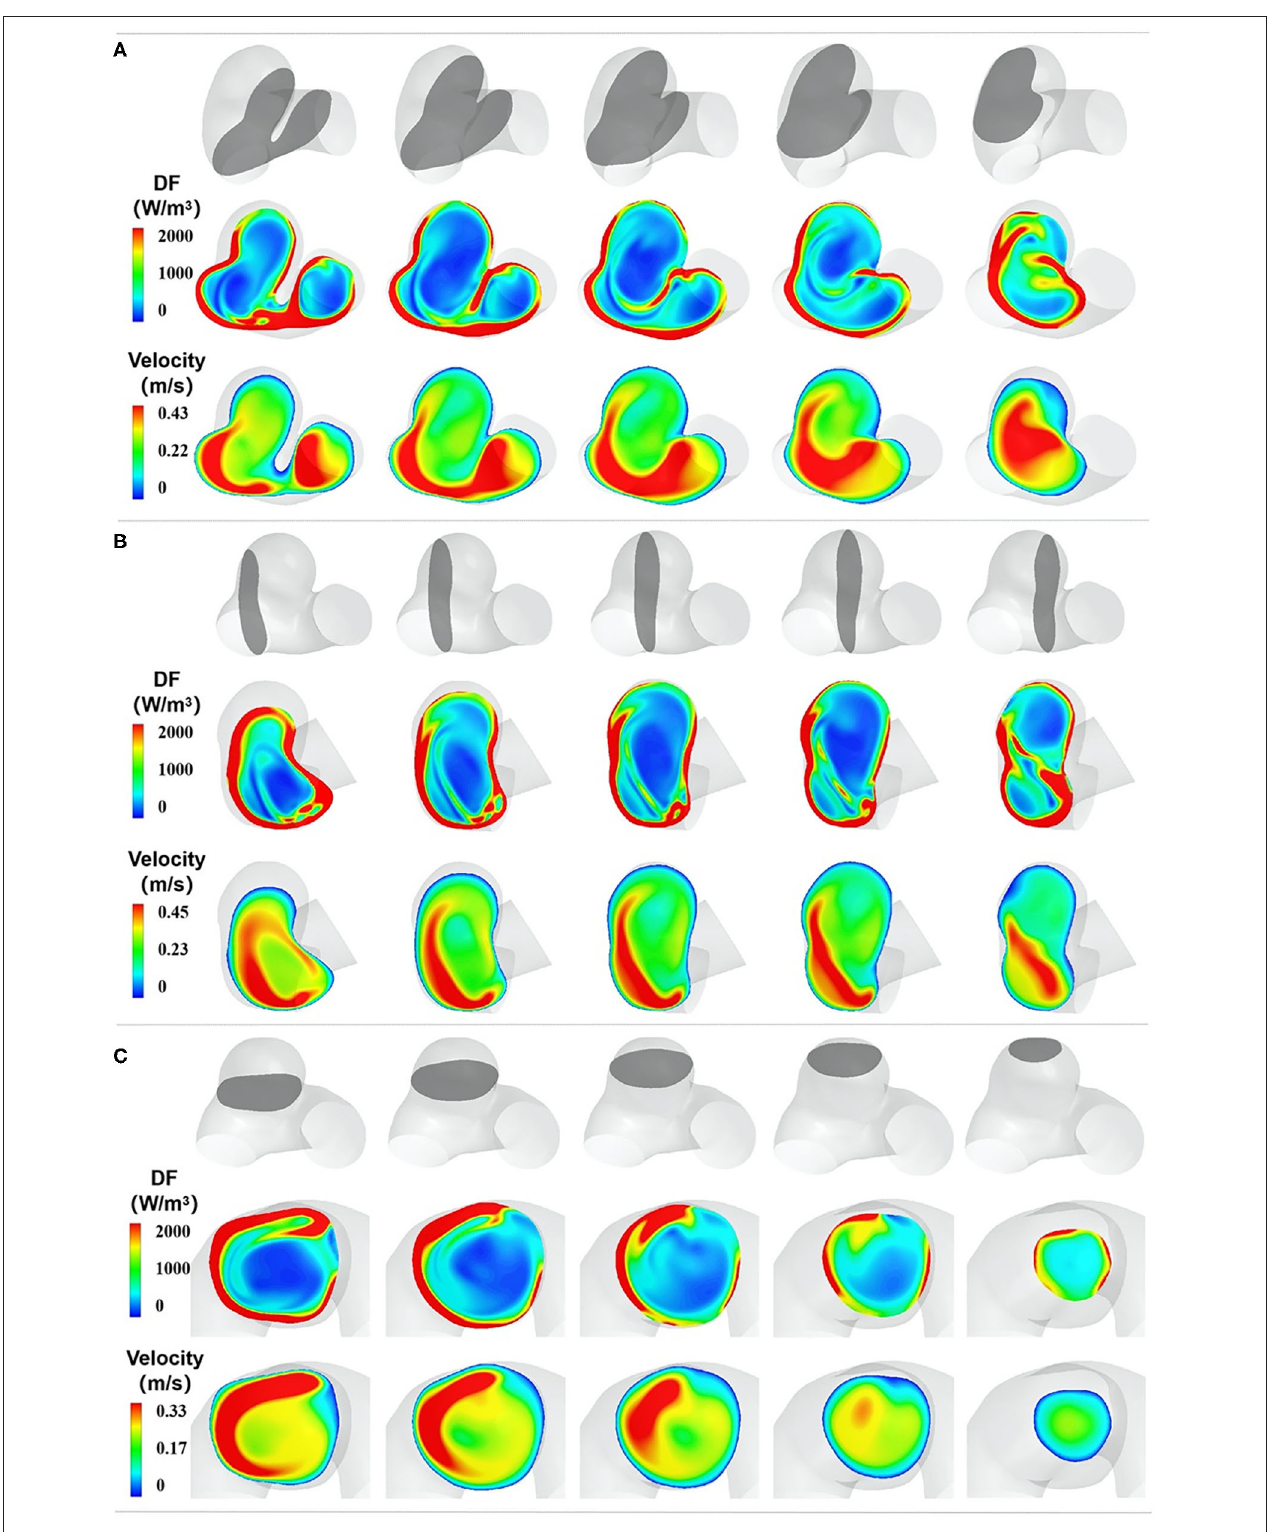
FIGURE 3 | The spatial characteristics of EL. (A–C) represent the DF distribution of three orthogonal cutting planes, respectively. In each section, the top row indicates the cutting plane, which is colored gray. The second row exhibits the DF distribution of the chosen plane, and the third row shows the velocity distribution of the chosen